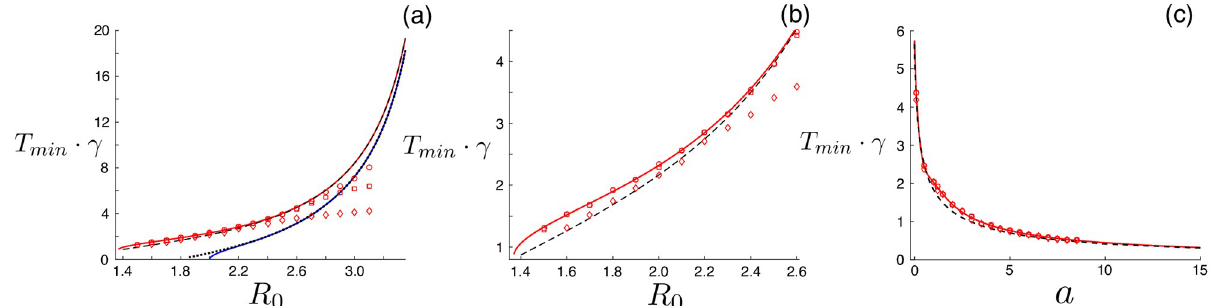
Fig 2. Optimal periodic closure. (a) Period versus R 0 = β 0 / γ . The solid-red and dashed lines are theoretical predictions (exact and approximate, respectively), and the points are simulation-determined minima for initial fractions infectious: 10 − 6 (circles), 10 − 4 (squares), and 10 − 2 (diamonds). The blue and dotted curves are predictions for the threshold closure period (exact and approximate, respectively). Other model parameters are: γ − 1 = 10 � days and α − 1 = 8.33 � days. (b) A refocused version of (a) for smaller values of R 0 . (c) Period versus a = α / γ . The color scheme and parameters are identical to (a), except β − 1 = 5.55 �